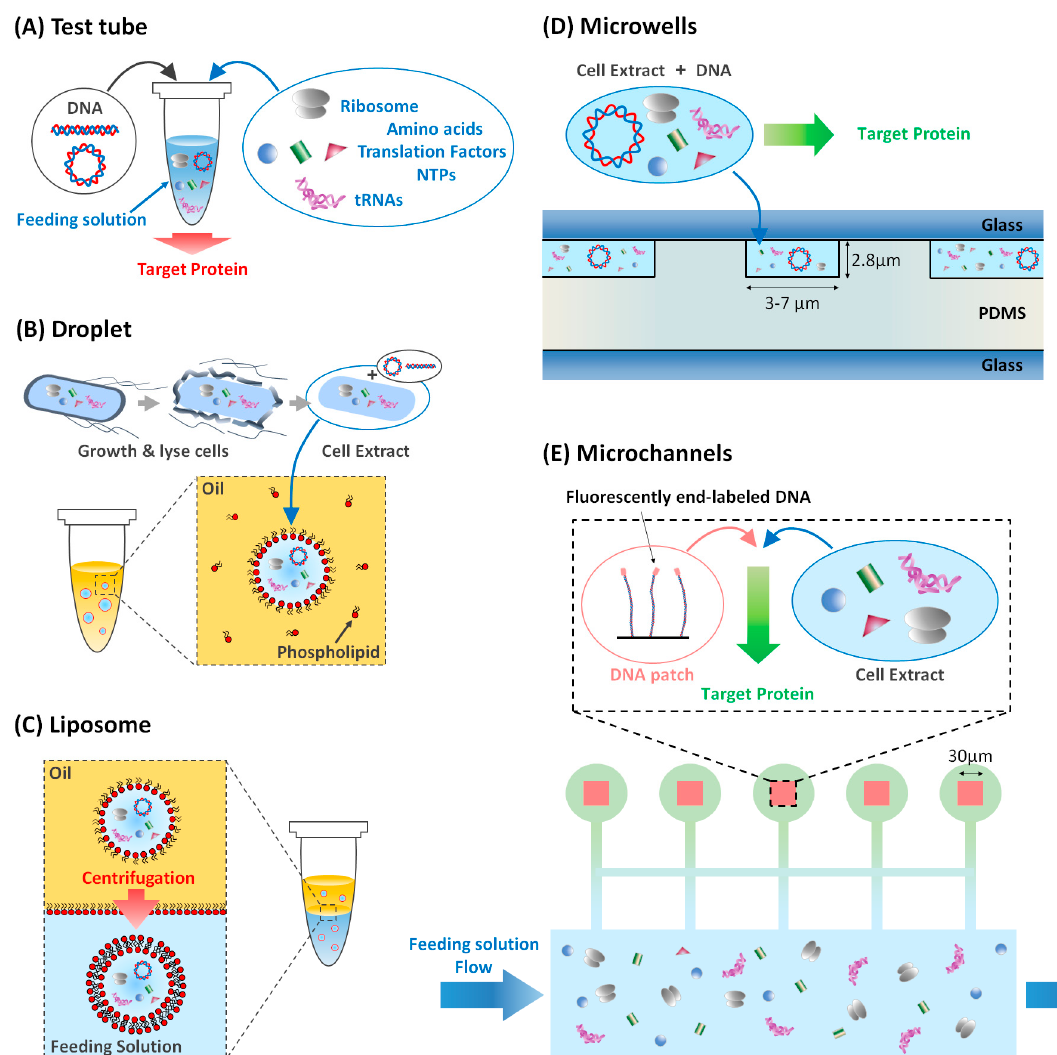
Figure 2. Cell-free TX-TL (transcription-translation) reactors in various compartments. ( A ) Test tube. Shimizu et al. have been developed the PURE system [13] in which purified transcription/translation factors, nutrients and DNA are incorporated into a test tube to produce target proteins. ( B ) Noireaux et al. have been developed TX-TL extract taken from bacteria Escherichia coli which contains TX-TL factors and nutrients to produce proteins [19]. PURE system and TX-TL extract can be encapsulated into a water-in-oil droplet, which recapitulates the micron-sized boundary of living cells [16]. ( C ) Liposome, which is covered with the lipid bilayer and surrounded by feeding solution, can be generated from the interface-transfer method by centrifugation through water-oil interface [19]. ( D ) Gasket design of a cylindrical cell-free genetic micro-reactor [21]. ( E ) Array of five coupled DNA compartments, communicating with a feeding solution as described in [22].